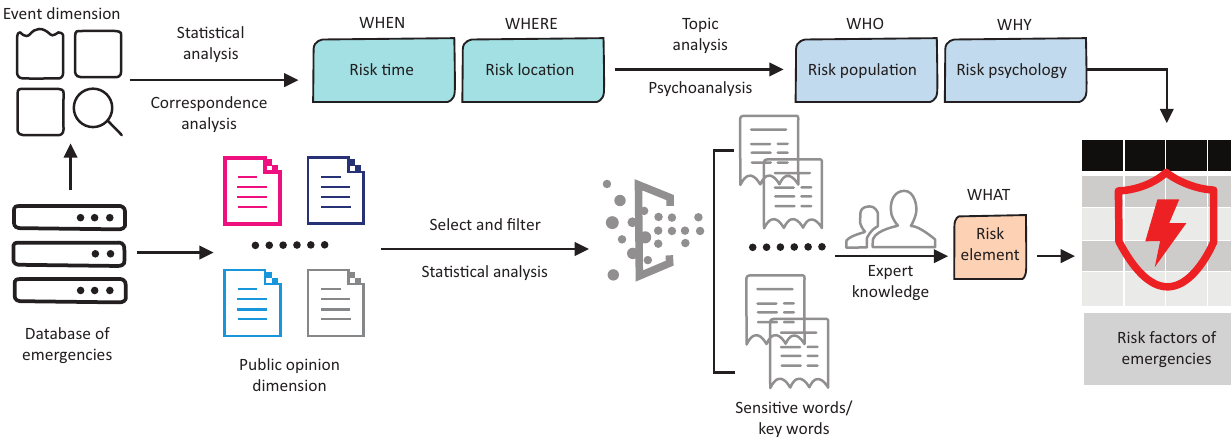
FIGURE 1: Method of labelling risk factors of emergencies.